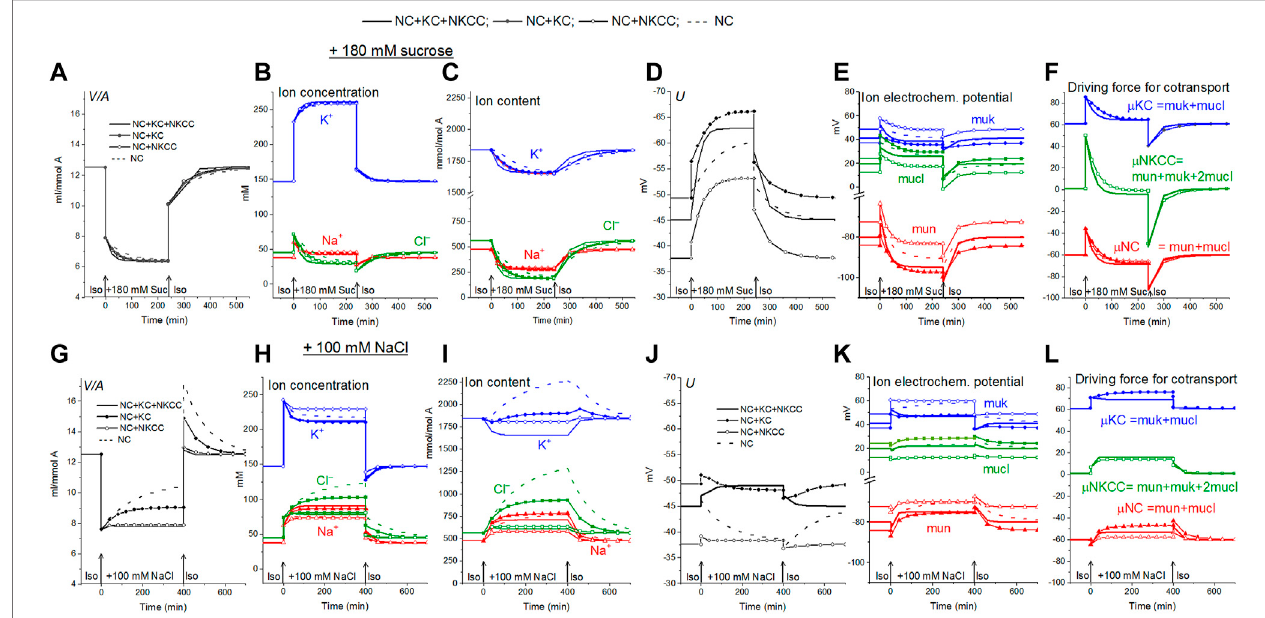
FIGURE1| Rearrangementofionic homeostasis followinganincreaseinexternalosmolaritydue toaddition of180 mMsucrose (A – F) or 100 mMNaCl (G – L) and a reverse transition to the normal medium, calculated for a model of U937 cells with different cotransporters and invariable in time parameters of channels and transporters like in U937 cells, equilibrated with the standard RPMI medium.